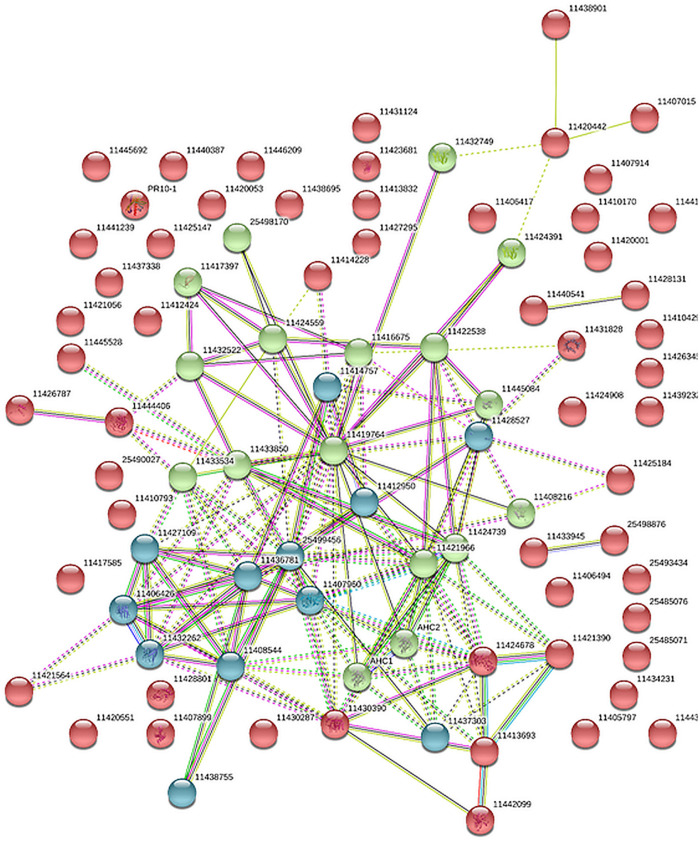
Protein association network analysis of the core stress response proteome (CSRP) using STRING. Colors (red, green cyan) are based on a kmeans cluster analysis (see also Supplementary Table S2).